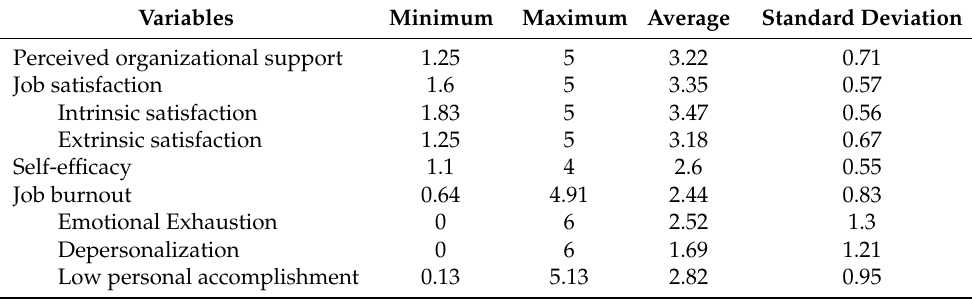
Table 2. Minimum, maximum, average, and standard deviation of variables and sub-variables.